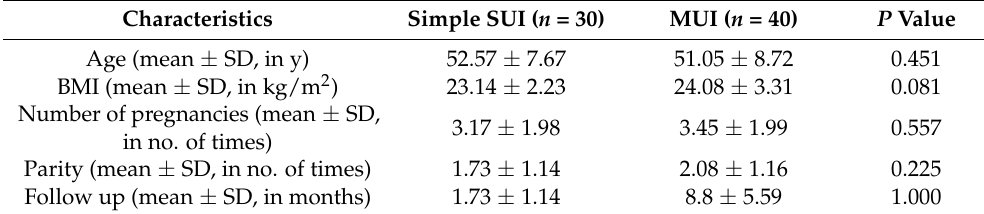
Table 1. Comparison of general data between simple SUI and MUI patients. Characteristics Simple SUI ( n = 30) MUI ( n = 40) P Value Age (mean ± SD, in y) 52.57 ± 7.67 51.05 ± 8.72 0.451 BMI (mean ± SD, in kg/m 2 ) 23.14 ± 2.23 24.08 ± 3.31 0.081 Number of pregnancies (mean ± SD, 3.17 ± 1.98 3.45 ± 1.99 0.557 in no. of times) Parity (mean ± SD, in no. of times) 1.73 ± 1.14 2.08 ± 1.16 0.225 Follow up (mean ± SD, in months) 1.73 ± 1.14 8.8 ± 5.59